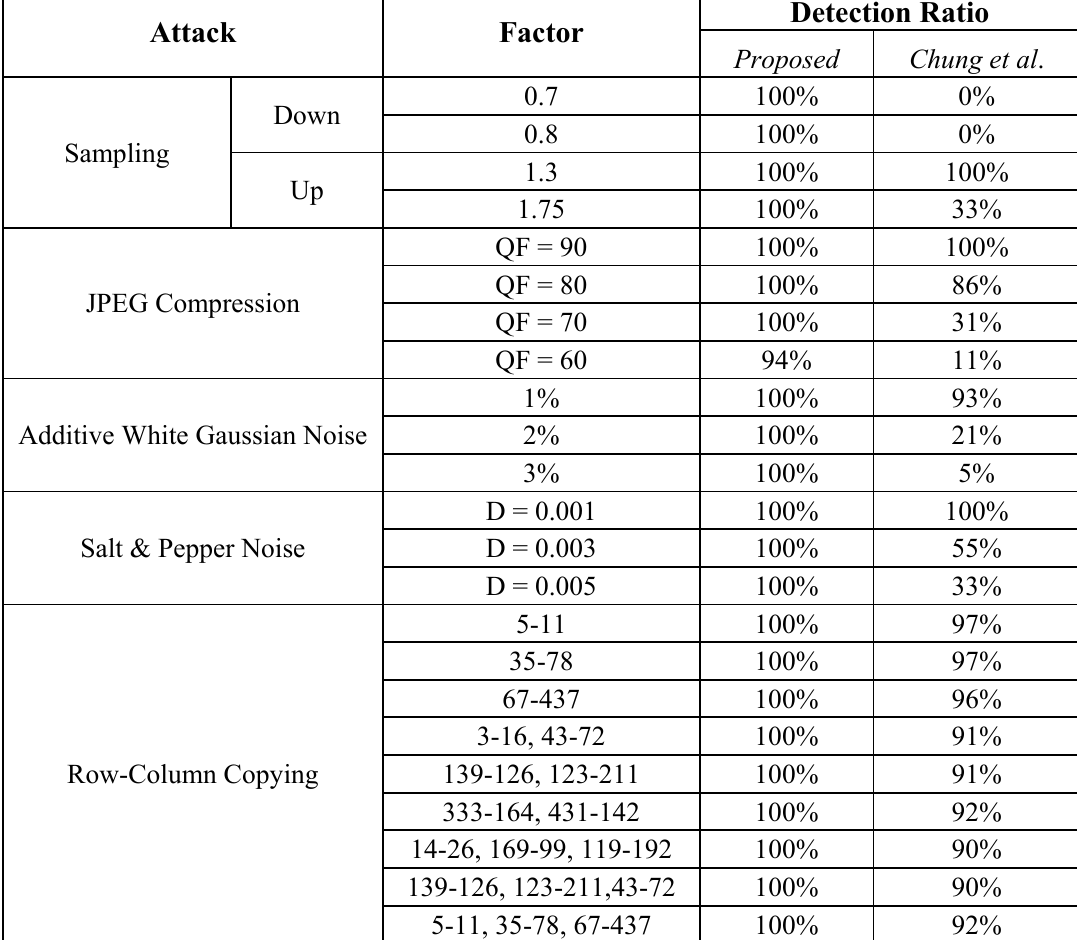
Table 3. Performance of our scheme compared to the Chung et al . [42]